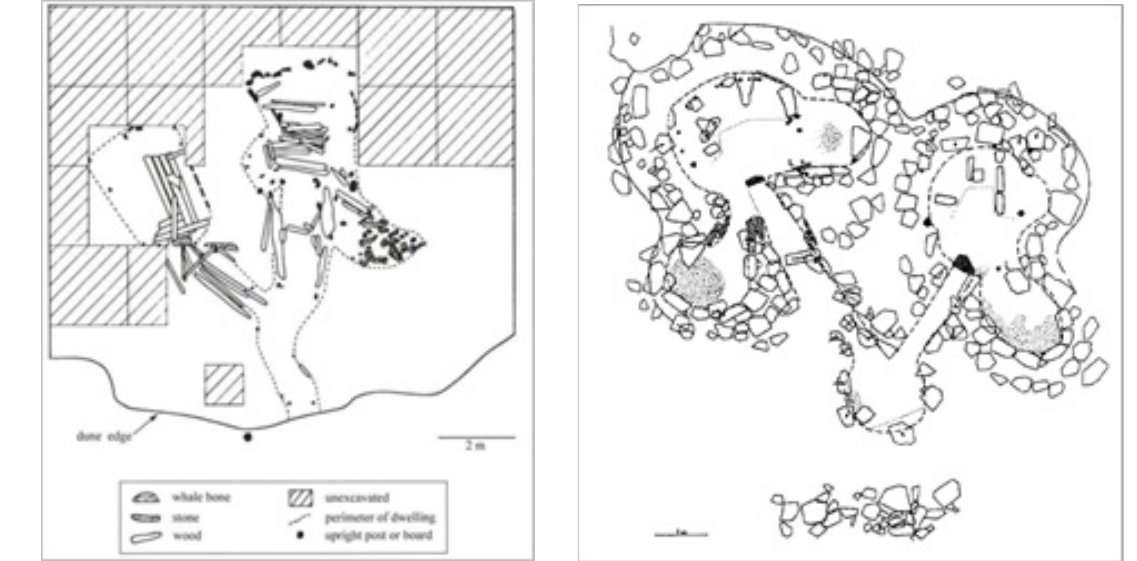
Figure 11: Nelson River (from Friesen and Arnold 2008: 530). Figure 12: Co-op, House 5 (from Le Mouël and Le Mouël 2002: